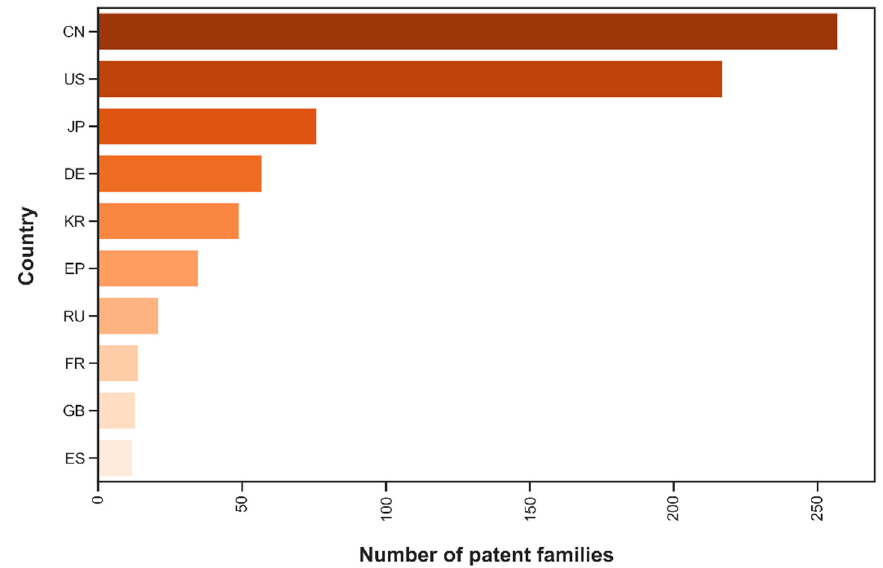
Figure 7. Distribution of patent families by priority country.